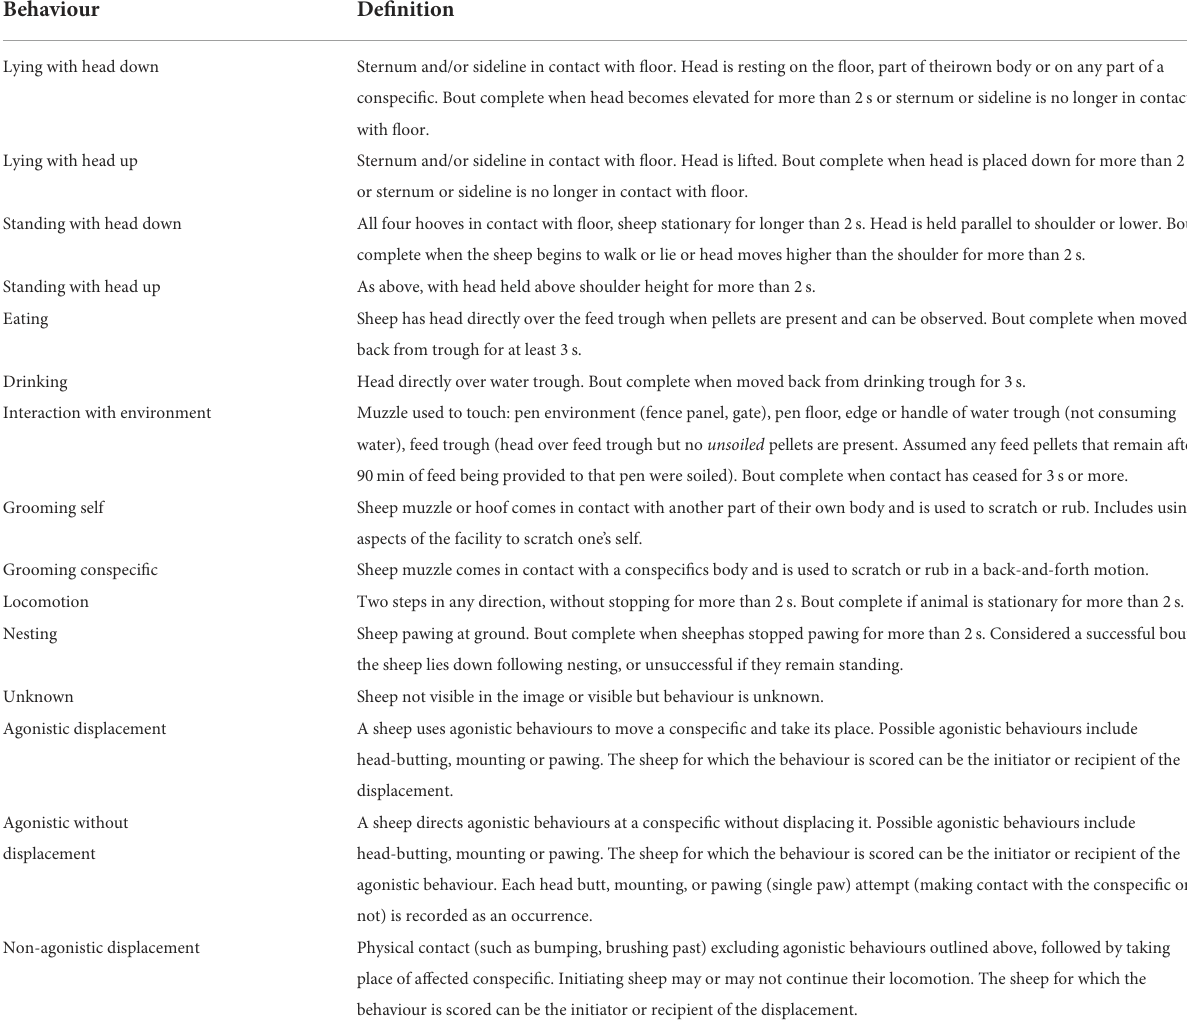
TABLE 2 Ethogram for categorising focal sheep behaviours during continuous observation periods.